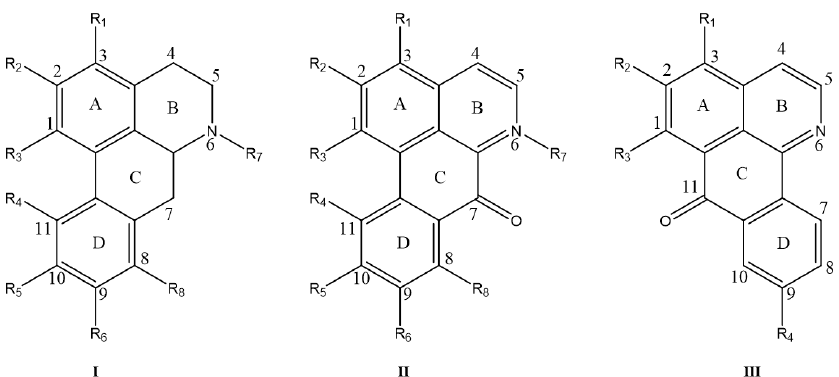
Figure 4. Structural skeletons of apomorphines and oxidized isoapomorphine alkaloids in M. Rhizoma.